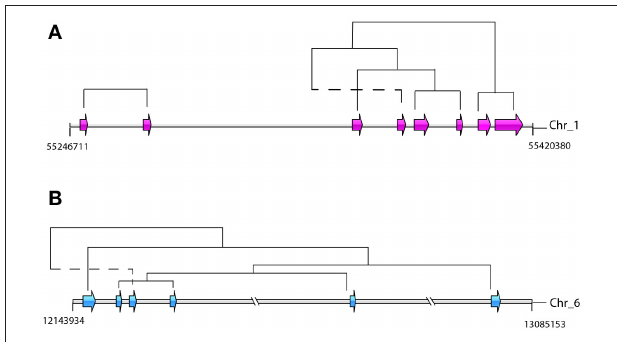
FIGURE 7 | Genomic organizations and origins of venom allergen proteins-coding genes. The phylogenetic relationships were determined by reconstructions of phylogenetic tree based on the whole gene family. Dotted lines indicate potential rearrangement of duplicated genes. (A) Tandem duplications of tegument-allergen-like proteins in chromosome 1. The pink arrows indicate the order and location of the genes (Smp_086470, Smp_086480, Smp_086530, Smp_169190, Smp_169200, Smp_195090, Smp_072620, and Smp_072630). (B) The tandem and proximal duplications of venom allergen-like proteins in chromosome 6. The blue arrows indicate the order and location of the genes (Smp_176180, Smp_176160, Smp_120670, Smp_154260, Smp_154290, and Smp_070250).